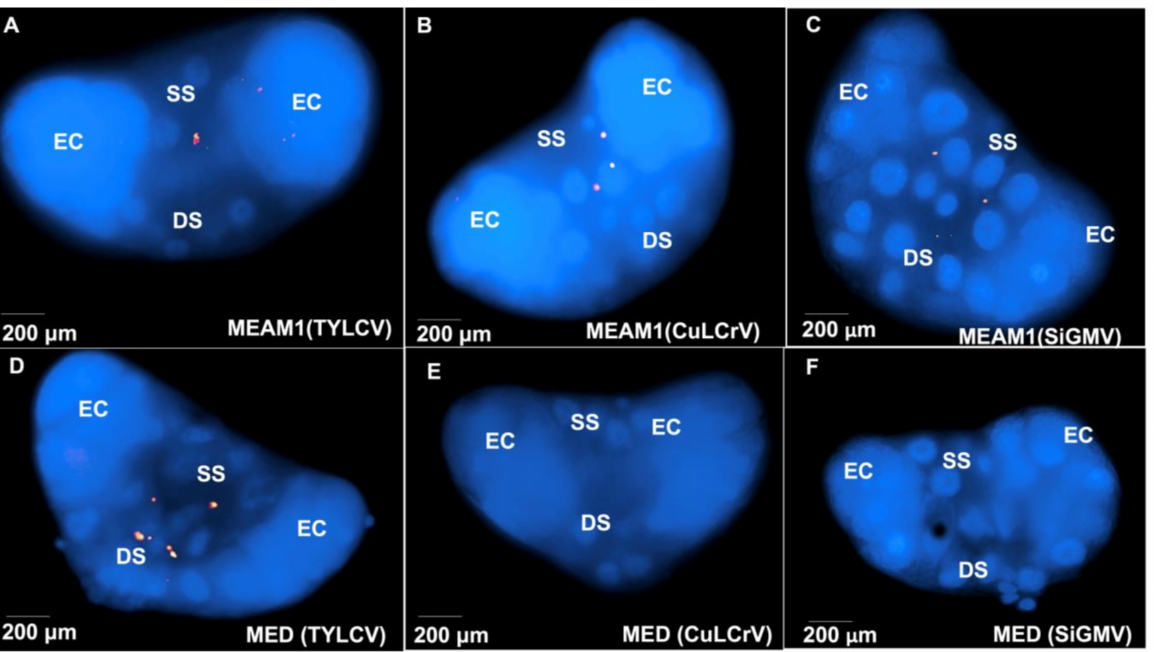
Figure 4. TYLCV, CuLCrV, or SiGMV localization in the primary salivary glands (PSG) dissected from B. tabaci adults (MEAM1 and MED) that fed on TYLCV-infected tomato,